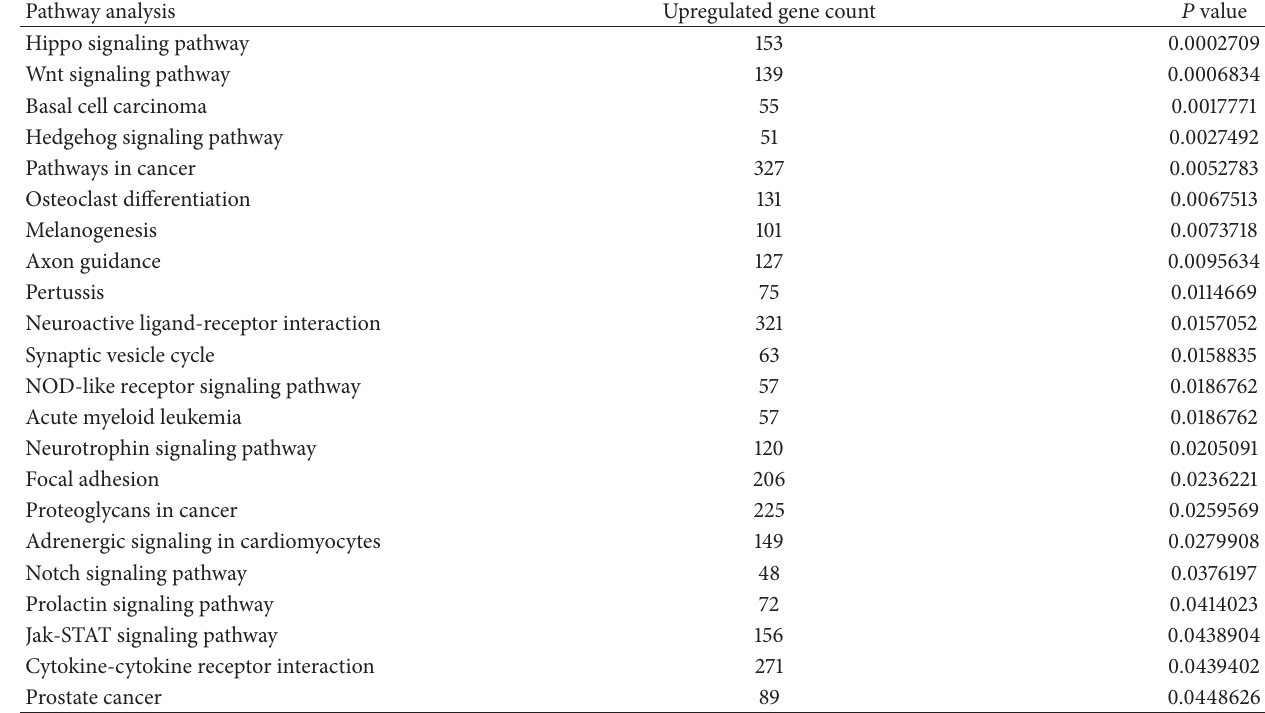
Table 2: Results of bioinformatics analyses on upregulated pathways in HUVECs after TGF 𝛽 1 (10ng/mL) stimulation. Pathway